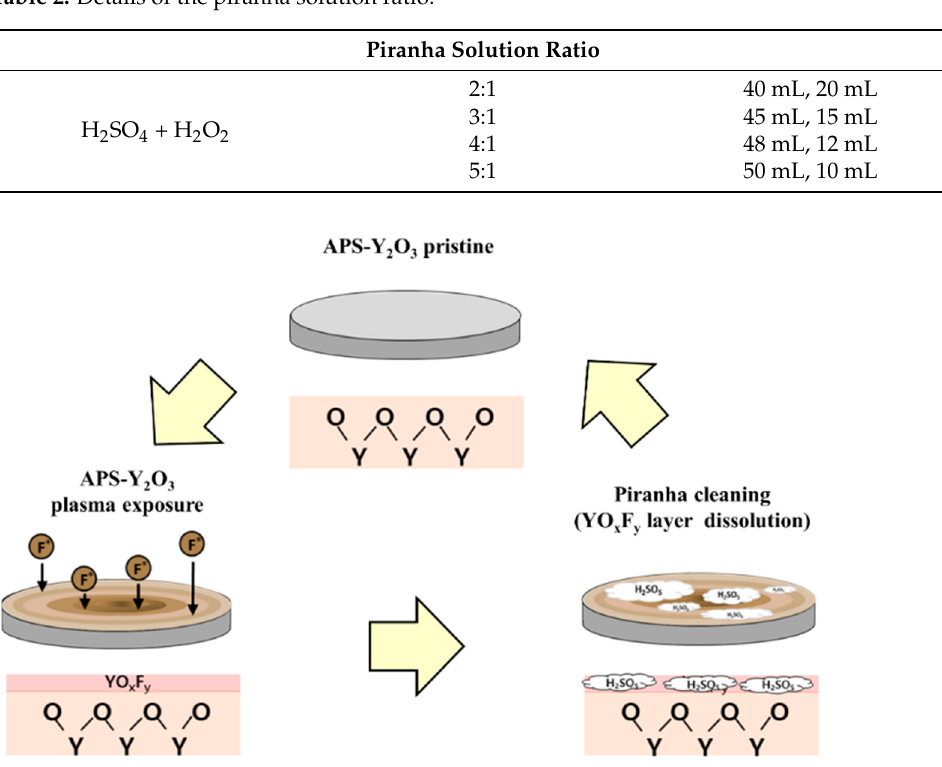
Figure 3. Schematic of cleaning experiments conducted to remove the fluorination layer on the APS–Y 2 O 3 coating surface.